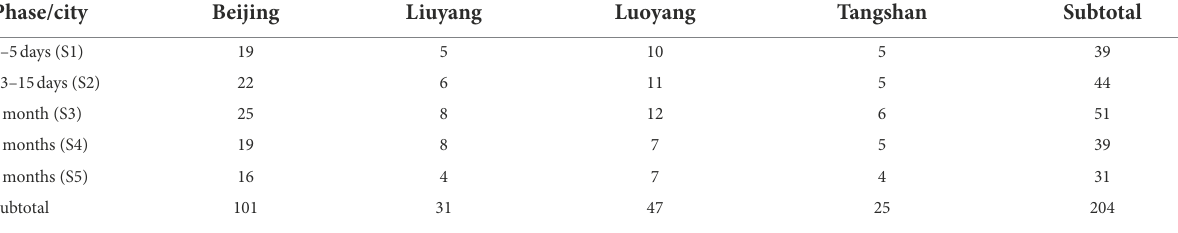
TABLE 1 Sample numbers of human breast milk by city and lactation phase.